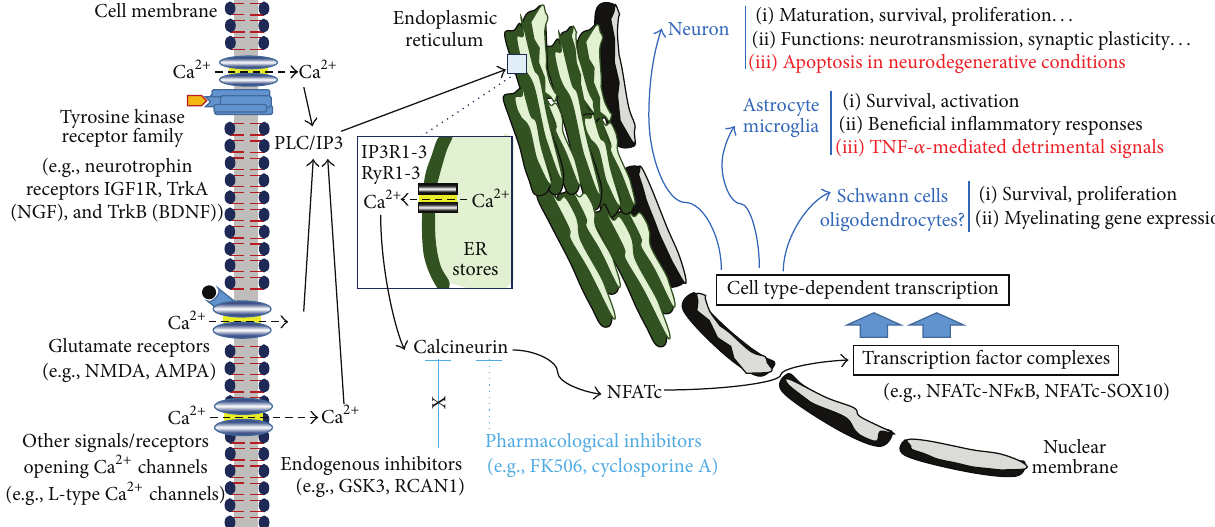
Figure 1: Calcineurin/NFAT signaling pathway. Calcineurin/nuclear factor of activated T-lymphocytes (NFAT) signaling activation in the nervous system is mainly induced by neurotrophins via their tyrosine kinase receptors, glutamate receptors, and nonligand-dependent receptors, such as voltage-gated Ca 2+ channels in hippocampal neurons. The genes transcribed and the effects of these signaling pathways are cell-type dependent. Abbreviations: AMPA, 𝛼 -amino-3-hydroxy-5-methyl-4-isoxazolepropionic acid; BDNF, brain-derived neurotrophic factor; GSK3, glycogen synthase kinase 3; IGF1R, insulin-like growth factor 1 receptor; IP 3 R, inositol 1,4,5-trisphosphate receptor; NF- 𝜅 B, nuclear factor kappa B; NFATc, Ca 2+ -regulated NFATs; NGF, neurotrophin nerve growth factor; NMDA, N-methyl-D-aspartic acid; RCAN1, regulator of calcineurin 1; RyR; ryanodine receptor; TrkA, tropomyosin receptor kinase type 1; TrkB, tropomyosin receptor kinase type